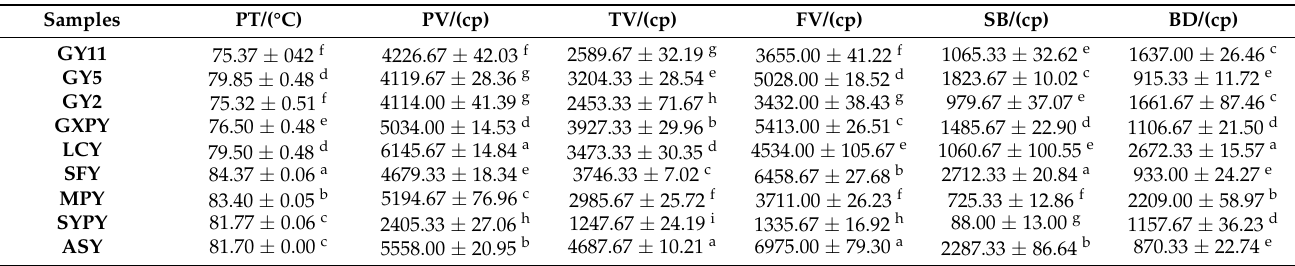
Table 2. The pasting properties of yam